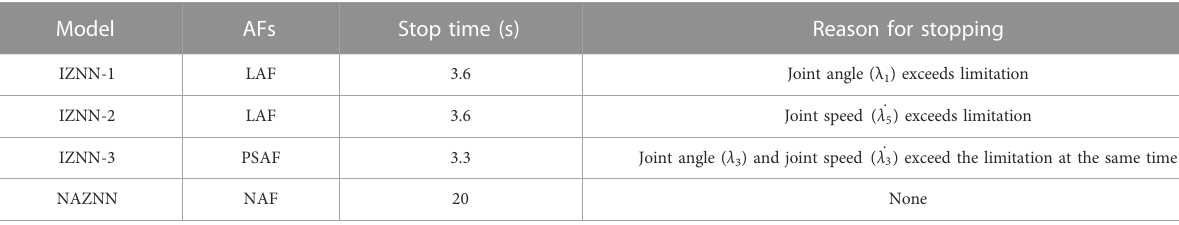
TABLE 3 Comparisons of ZNN models for trajectory tracking